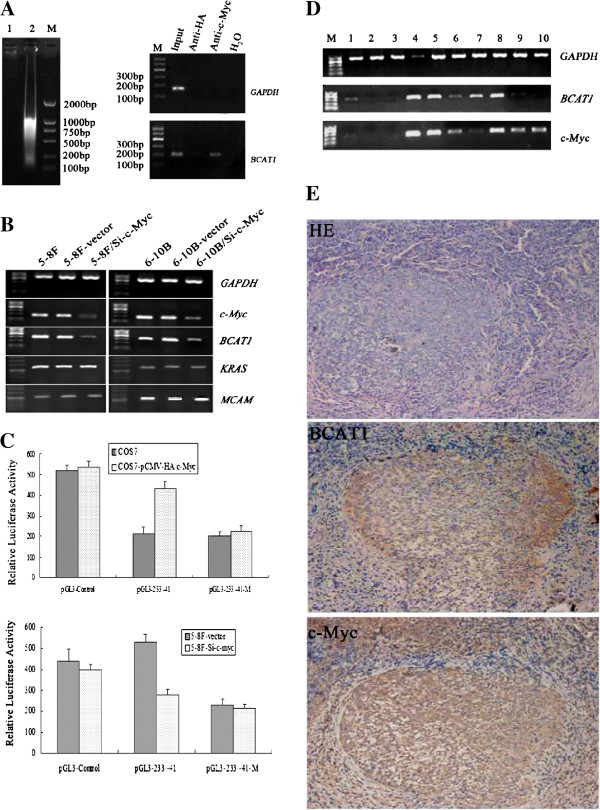
The regulation of BCAT1 by c-Myc. (A) ChIP confirmed that transcription factor c-Myc can specifically bind to the regulatory region of BCAT1. Lane 1 and 2 represent gDNA untreated or treated with ultrasonication, respectively. (B) Detection of the mRNA level of BCAT1 in 5-8F cells and 6-10B cells transfected with pRNAT-U6.1/Si-c-Myc vector or blank vector. BCAT1 mRNA level was reduced when the endogenous expression of c-Myc was blocked both in 5-8F cells and 6-10B cells, while the expression of KRAS or MCAM, two non-target genes of c-Myc, was stable despite the change of c-Myc’s level in these cells. (C) Luciferase reporter assay demonstrated the influence of c-Myc on BCAT1 promoter activity. The results showed that the luciferase activity was positively correlated to the expression level of c-Myc. Here, we used 5-8F-vector cells instead of 5-8F cells as control. (D) The co-expression of BCAT1 and c-Myc was detected in NPC tissues by RT-PCR. Lanes 1–3 represent BCAT1 and c-Myc expression in CN tissues. Lanes 4–10 represent BCAT1 and c-Myc expression in NPC tissues. GAPDH was used as an internal control. (E) IHC analysis of the same batch of NPC biopsies demonstrated that BCAT1 and c-Myc were co-expressed in most NPC tissues.